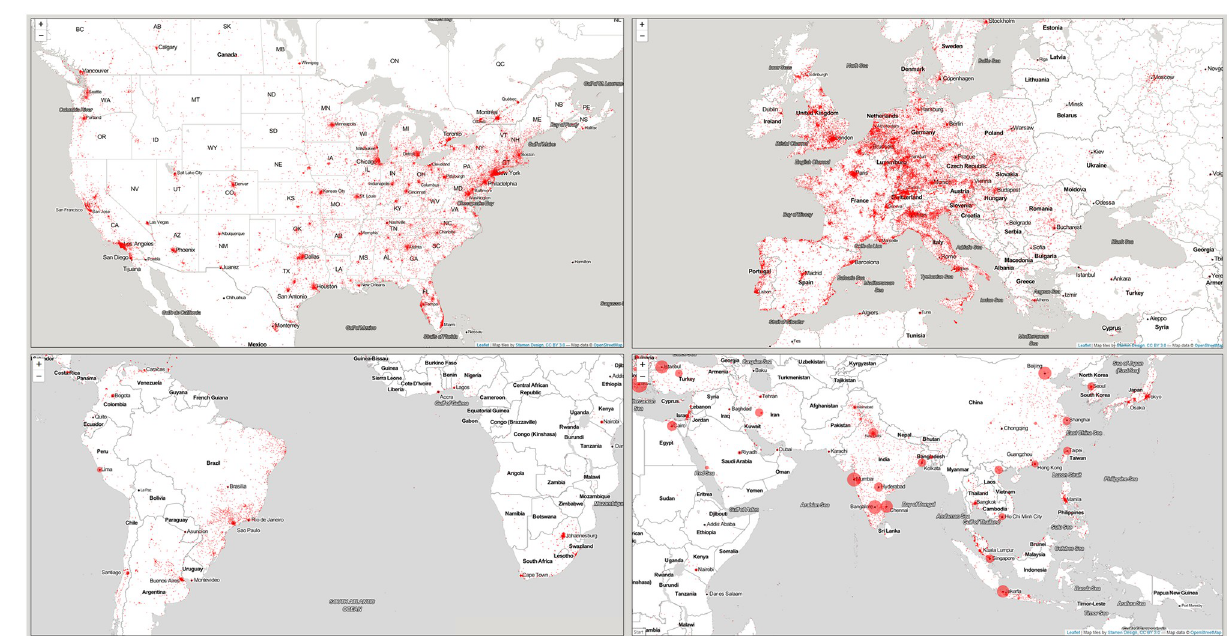
Fig 2. Geographical distribution of download locations aggregated over the total observation